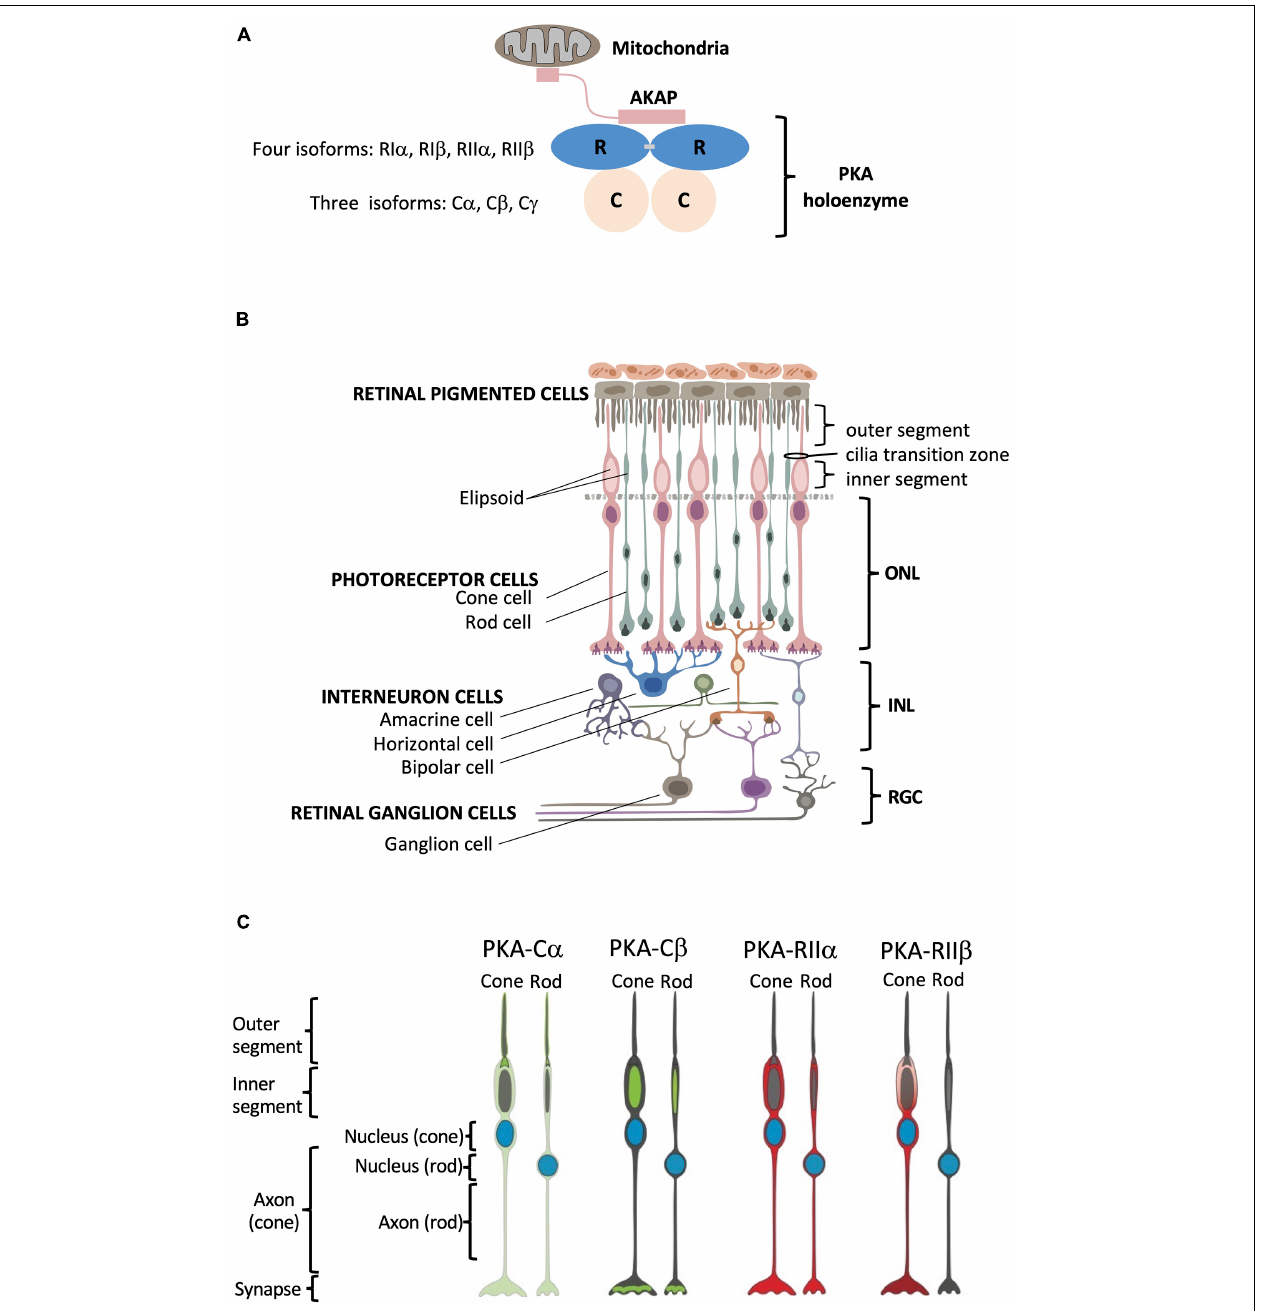
FIGURE 1 | Structural organization of PKA and human retina. (A) Schematic of PKA. In the inactive state two catalytic subunits are bound by a regulatory subunit dimer, which is typically anchored to intracellular locations such as the mitochondria by AKAP proteins. (B) Retina consists of six neuronal cell types: cone, rod, horizontal, bipolar, amacrine, and ganglion cells. These six cell types are organized into three main layers within the retina that include the outer nuclear layer (ONL) with the nuclei of cones and rods, the inner nuclear layer (INL) with nuclei of interneuron horizontal, bipolar, and amacrine cells, and the retinal ganglion cell layer (RGC) that contains ganglion cell nuclei. Photoreceptor cone and rod cells directly accept photons in the specialized part of the cell called the outer segment, and they contain a mitochondrion-enriched ellipsoid in the inner segment, with the area connecting the outer and inner segment referred to as the cilia transition zone. RPE cells (top) are phagocytosis-competent cells indispensable for daily outer segment renewal. For interneurons: horizontal cells communicate with photoreceptors; bipolar cells communicate with both photoreceptor and retinal ganglion cells; and amacrine cells communicate with retinal ganglion cells. Retinal ganglion cells convey the visual information to the brain. (C) Summary of PKA localization in cone and rod photoreceptor cells. C α : outer segment membrane, base of the connecting cilium, cell body, axon, and synapse of cone and rod cells. C β : inner segment mitochondrion-enriched ellipsoid of cone and rod cells, as well as in the synaptic region. RII α : cell body, axon, and synapse of cone and rod cells. RII β : cell body, axon, and synapse of cone cells.